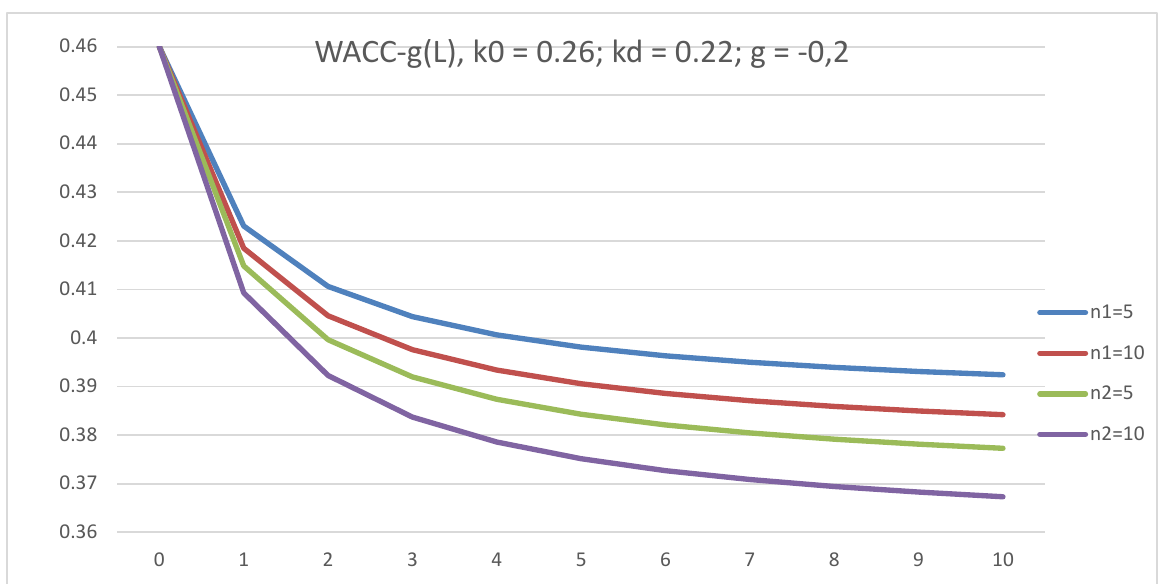
Figure 11. The dependence of discount rate, WACC–g, on leverage level, L, in GBFO theory with payments of tax on profit at the end of periods (1) and advance payments (2) at k 0 = 0.26; k d = 0.22; t = 0.2; g = − 0.2, for five-year and ten-year companies.